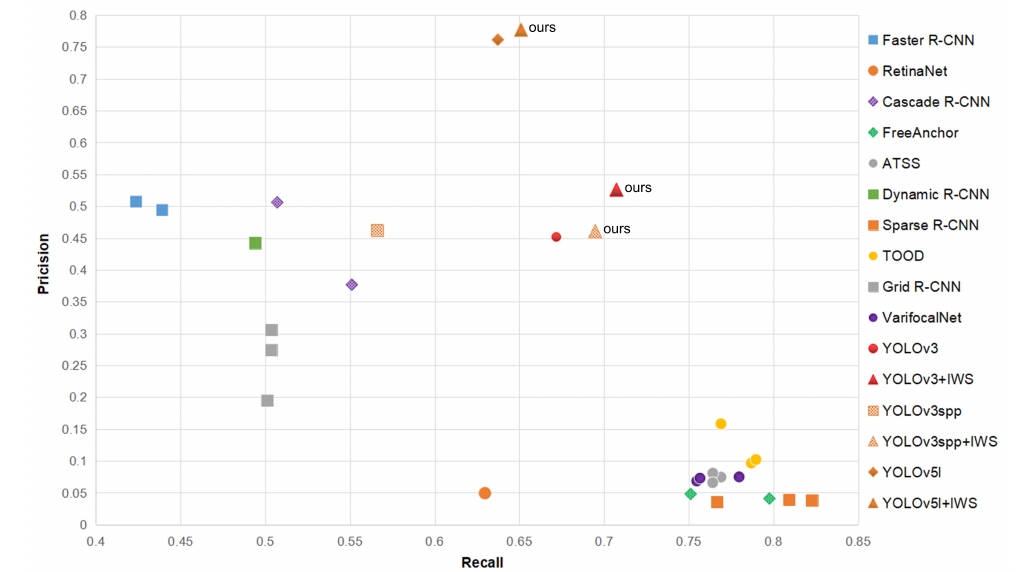
Figure 4. Our models have better effect than other competitive